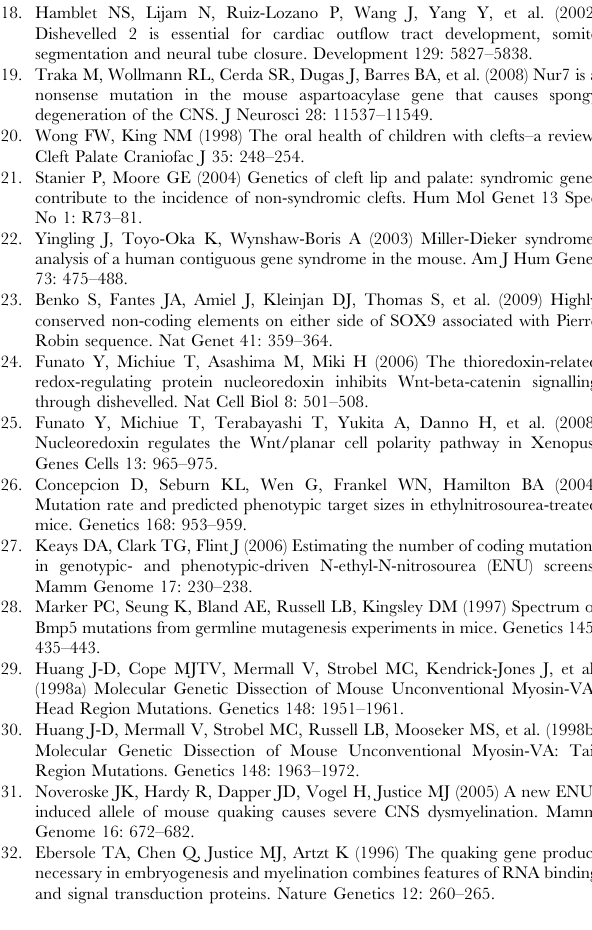
Table S5 Allelic series found. Exon number, intron numbers, and the size of the genomic loci are taken from Ensembl version 34. 1 Four additional lesions found in Aipl1 , Atp6v0a1 , Plxdc1 , and Socs7 . 2 One additional lesion found in Tmigd1 . 3 Two additional lesions found in Plekhm1 , RP23-263M10.5 . 4 One additional lesion found in Olfr394 . 5 Three additional lesions found in Centb1 , Gip , Mpdu1 .